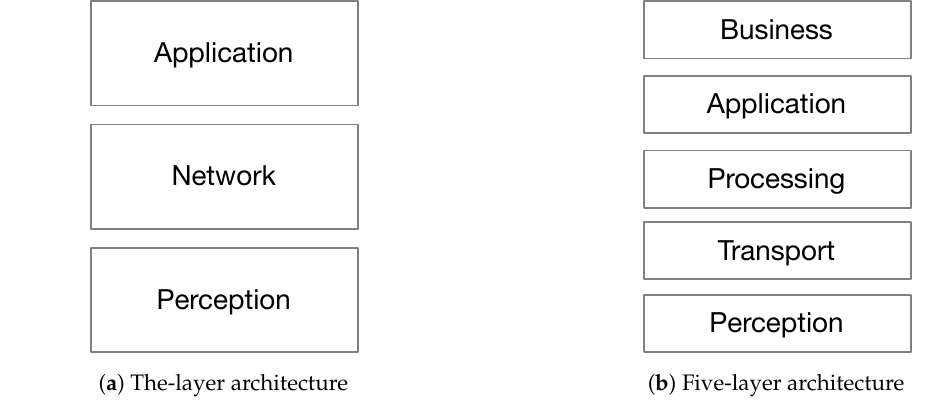
Figure 1. IoT architecture